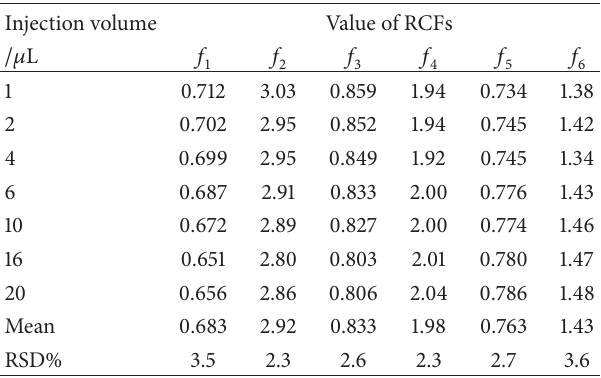
Table 4: The values of 𝑓 calculated under different injection volumes ( 𝑛 = 3 ).